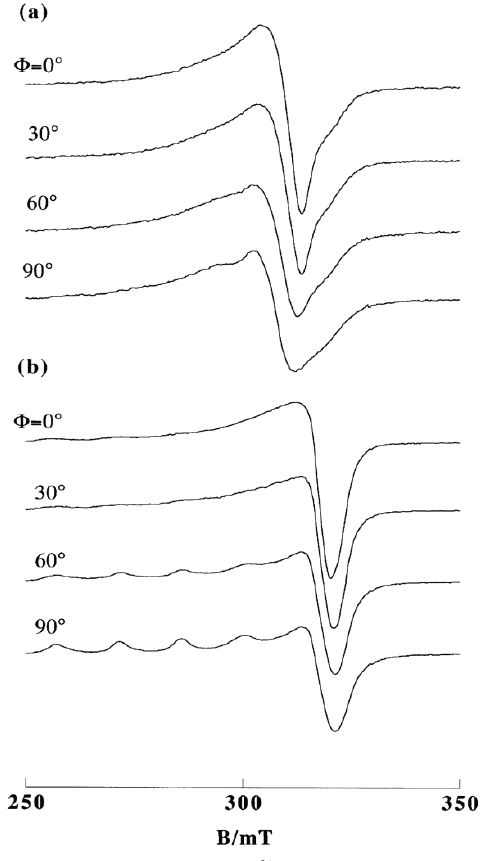
Figure 5. EPR spectra of [Cu(2,9-dmp)(H 2 O) 3 ] 2+ on B-form DNA fibers at ( a ) room temperature and ( b ) − 150 °C. [DNA-bp]/[Cu(II)] = 30 [27].